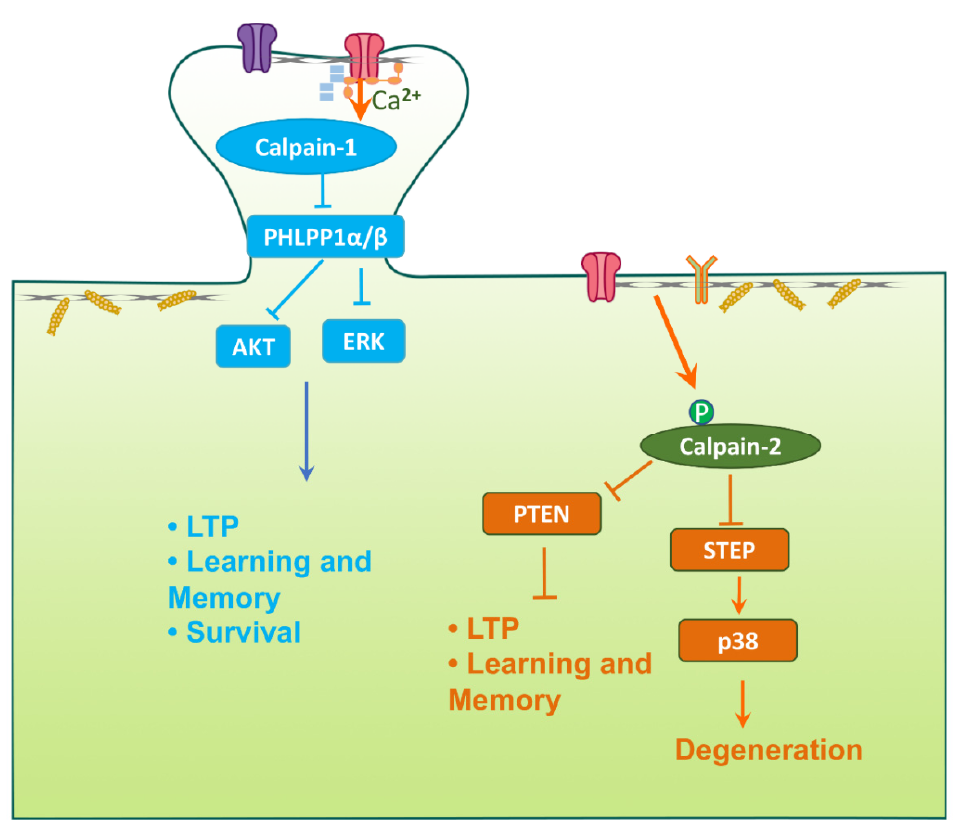
Figure 6. Di ff erent subcellular locations and functions of calpain-1 and calpain-2 in excitatory neurons. Calpain-1 is preferentially linked to synaptic N-Methyl-D-Aspartate (NMDA) receptors while calpain-2 is downstream of extra-synaptic NMDA receptors in neurons. Synaptic NMDAR activation activates calpain-1, which cleaves and inhibits PHLPP1 α / β . PHLPP1 α / β inhibits AKT and ERK. Thus, calpain-1-mediated cleavage of PHLPP1 activates AKT and ERK, which trigger long-term potentiation (LTP) and promote neuronal survival. On the other hand, extra-synaptic NMDAR activation induces phosphorylation and prolonged activation of calpain-2. Calpain-2 cleaves its substrates such as PTEN and STEP, leading to reduced LTP magnitude and neurodegeneration.